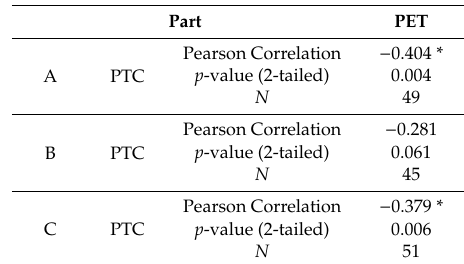
Table 13. Pearson correlation analyses between PET and